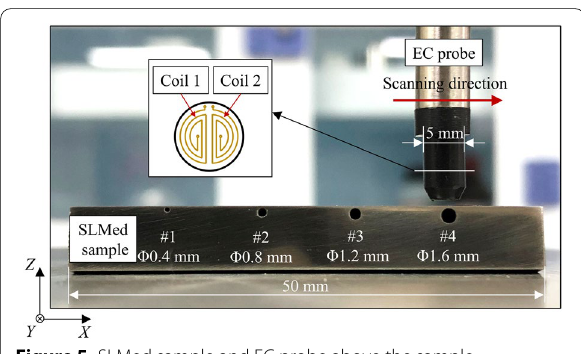
Figure 5 SLMed sample and EC probe above the sample